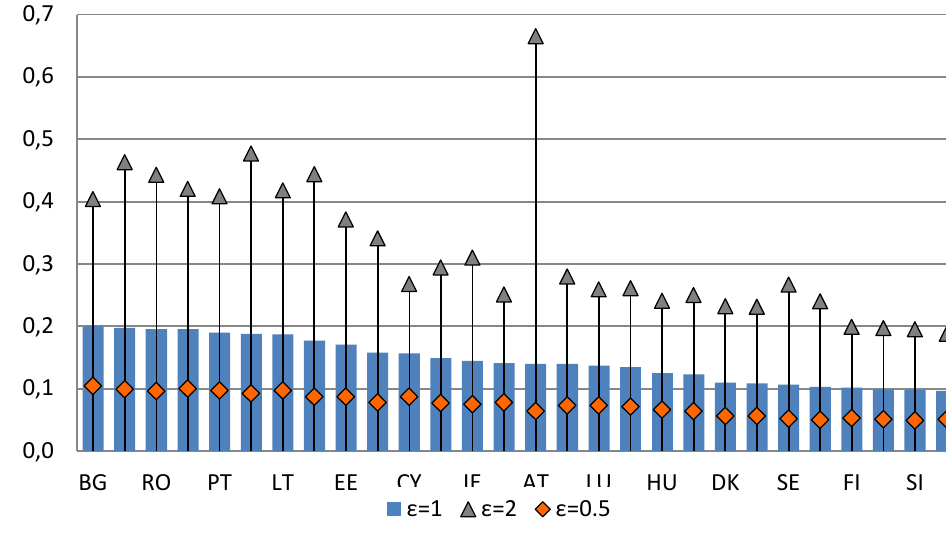
Figure 10 . Atkinson indices for the EU-28 countries (2012). Source: Own elaboration based on statistics from the European Commission. Note: Countries appear ranked according to the highest Atkinson index